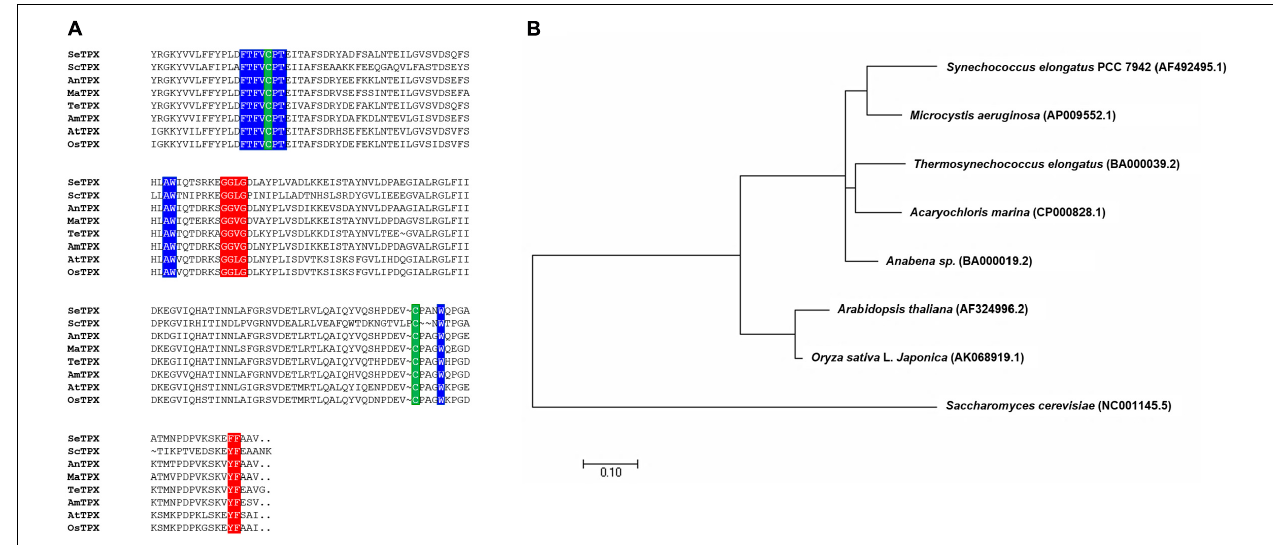
FIGURE 2 | Alignment of TPXs. (A) Alignment showing highly conserved active site regions and highly conserved redox-active disulfide bridge cysteine. Backgrounds indicate: TPX active site regions with GGLG and YF (red backgrounds), FTFVCPT, AW, and W (blue backgrounds); cysteine residues involved in disulfide bridges (C and C; green backgrounds) (B) phylogenetic tree of OsTPX and other TPX s.